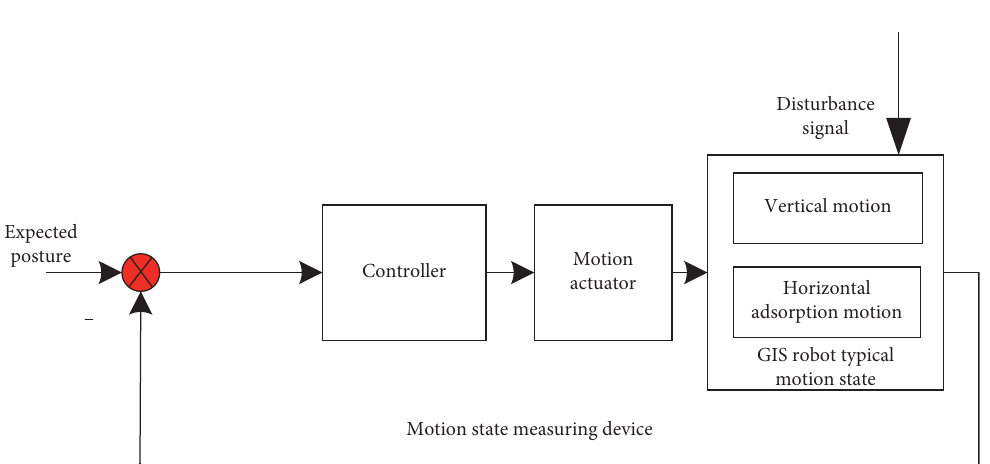
Figure 6: GIS inspection robot controller structure diagram.